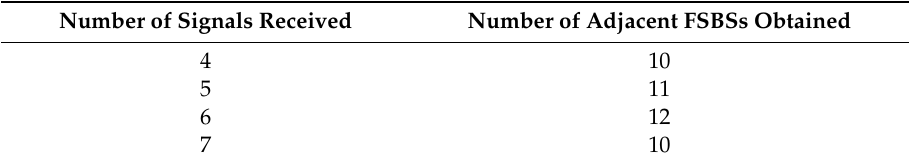
Table 2. Number of adjacent FSBSs.